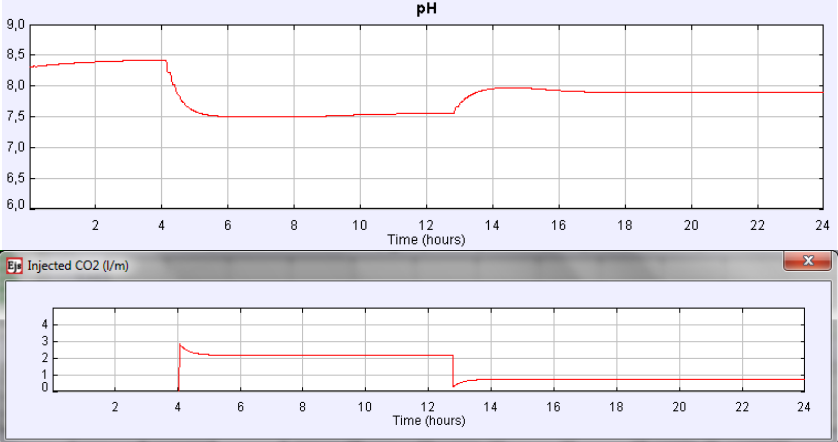
injected flow rate 2